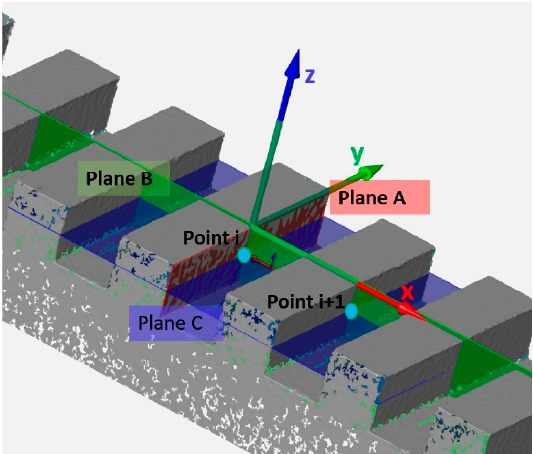
Figure 2. Definition of the 3-planes intersection points used for the lengths definition. The picture refers to a reconstructed mesh of the polyphenylene sulfide PPS step gauge.